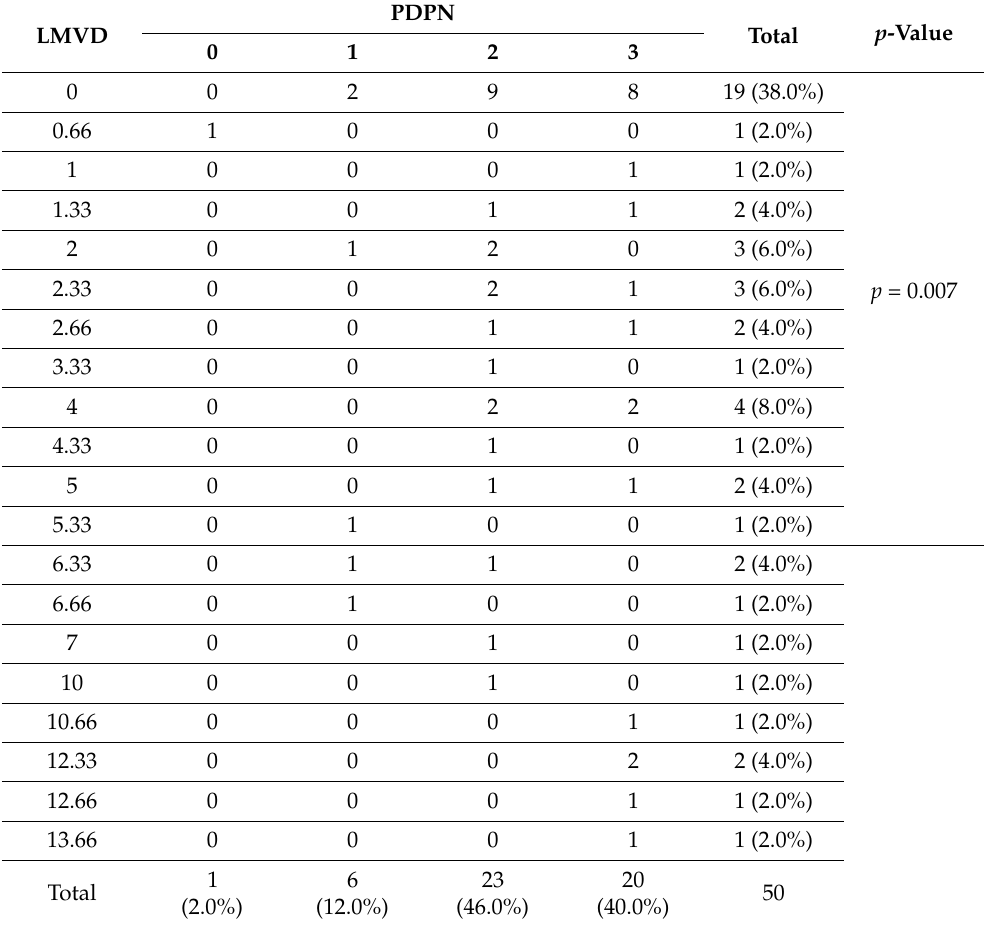
Table 3. Lymph microvessel density (LMVD) correlation with podoplanin (PDPN)